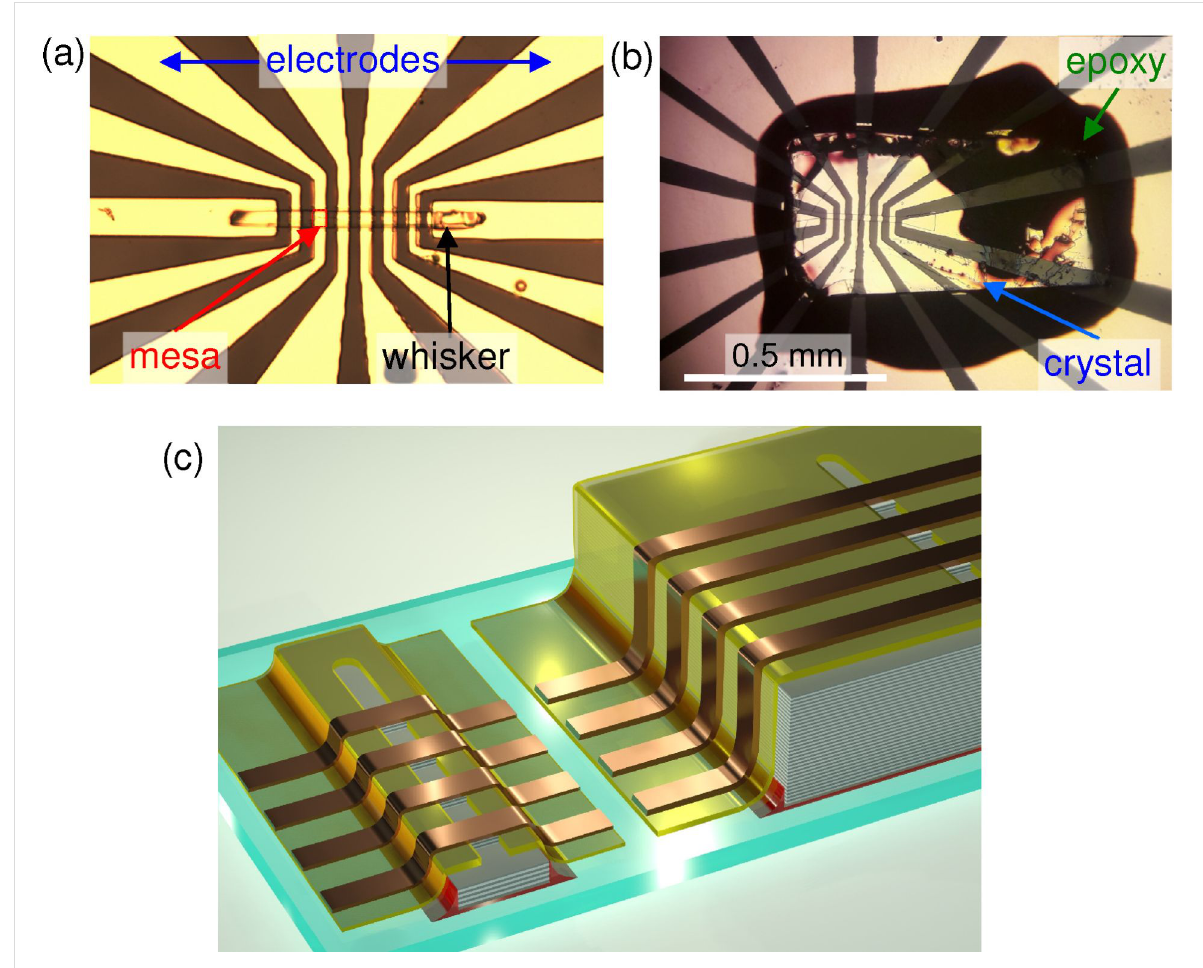
Figure 1: Optical images of (a) a whisker and (b) a crystal-based device with similar electrode geometries. (c) A sketch of both devices.